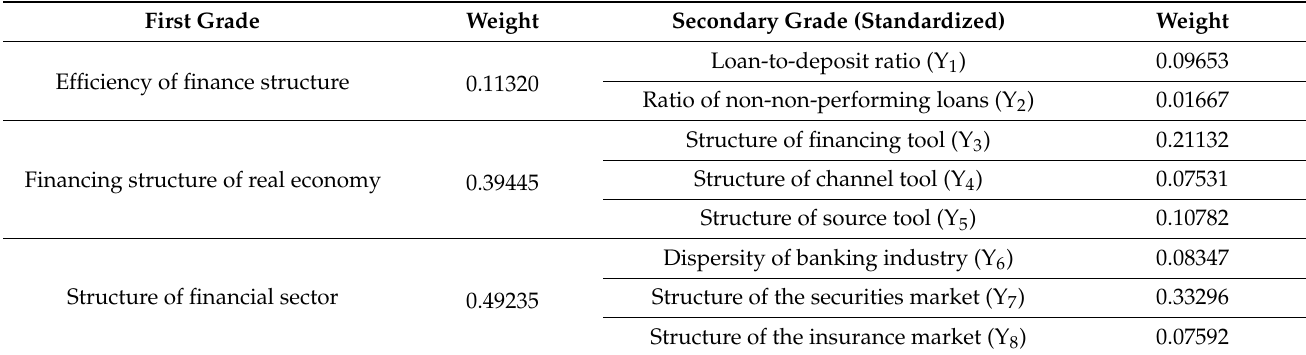
Table 2. The weight of each index in the finance structure index system of